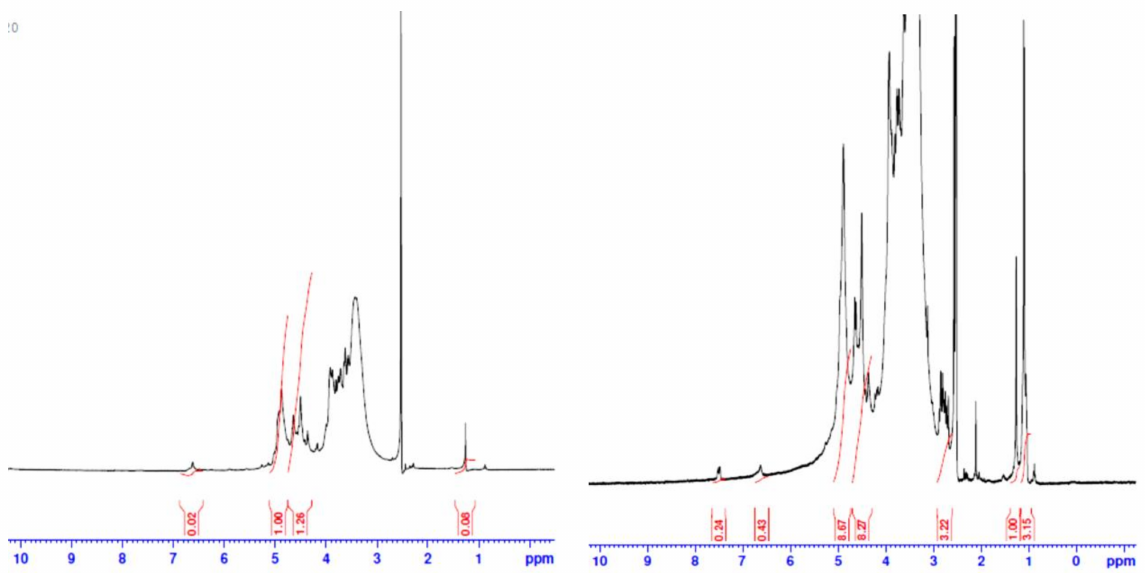
Figure 6. H NMR spectrum of alginic acid (in left side) and its aromatic derivative (in right side). Functionalization of alginic acid with benzoyl chloride generated a new peak at 7.4–7.5 for aromatic